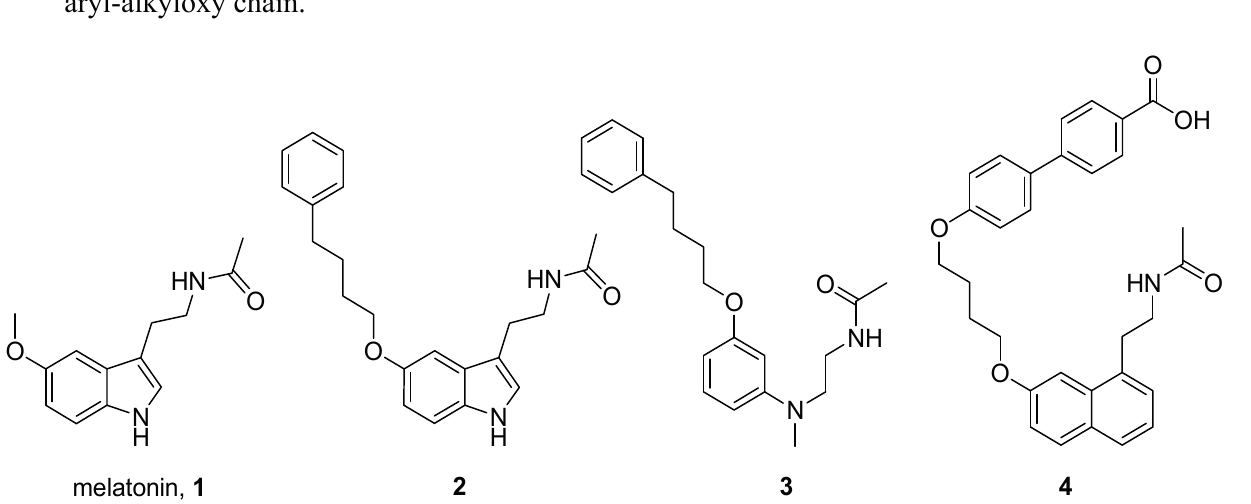
Figure 1. Structures of melatonin and of MT 1 -selective compounds bearing an aryl-alkyloxy